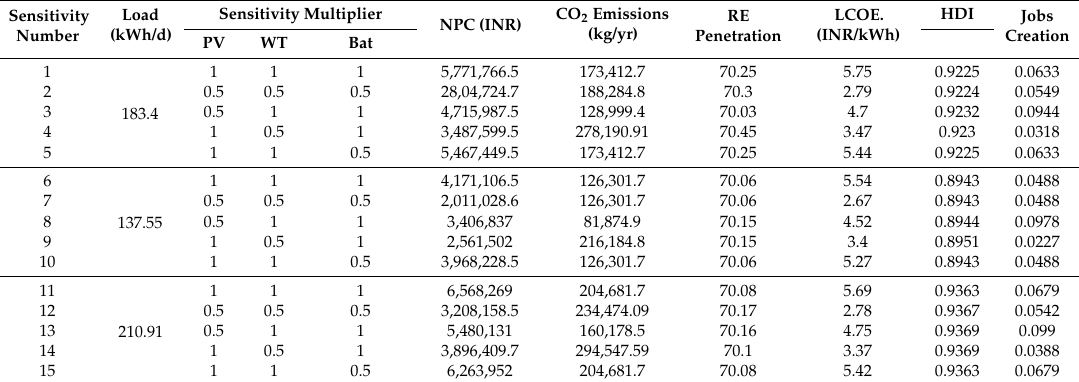
Table 3. Results of all sensitive cases with the lowest value of